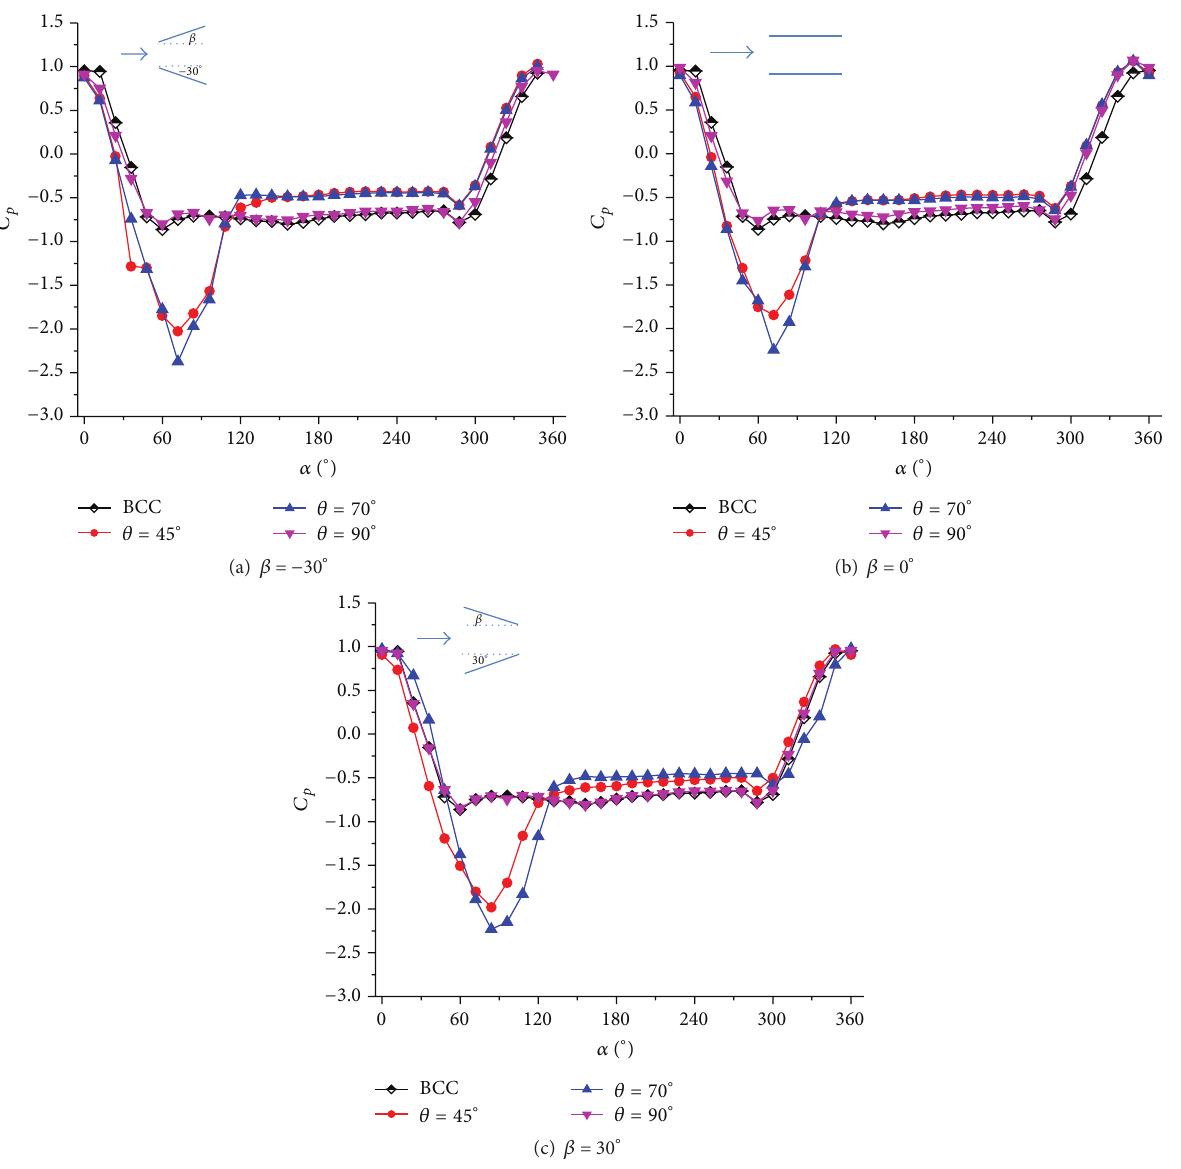
Figure 9: Distribution of the mean pressure coefficients ( 𝑈𝑟 = 7